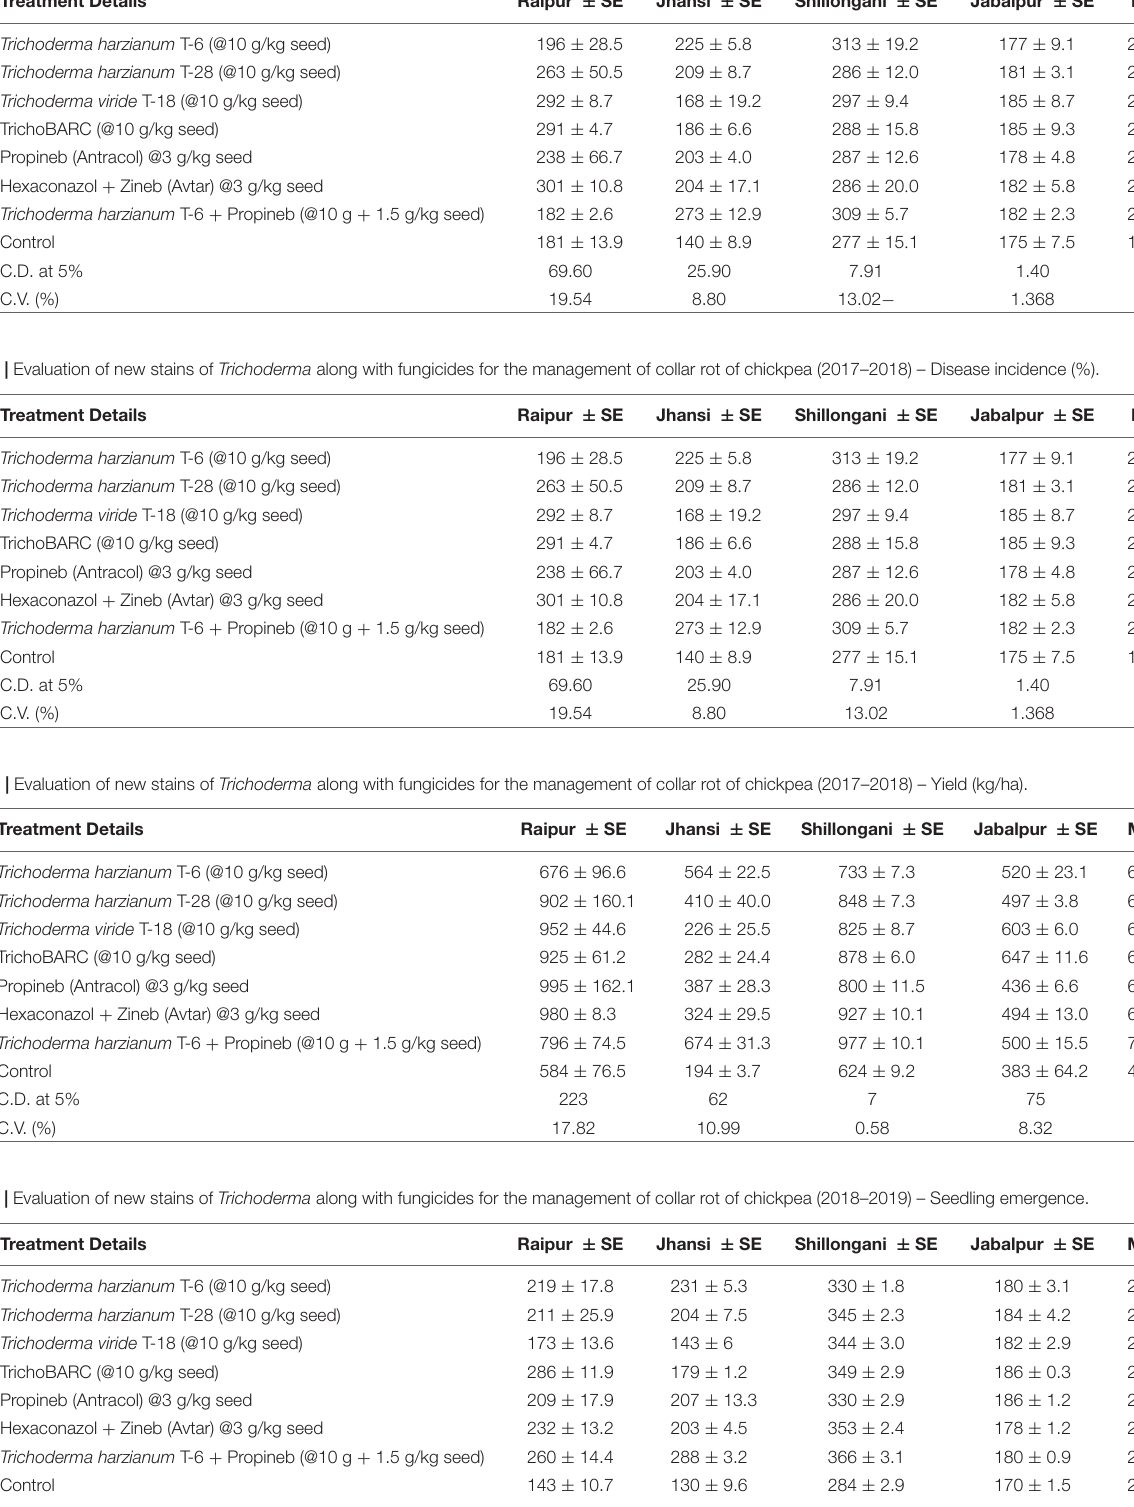
TABLE 2A | Evaluation of new stains of Trichoderma along with fungicides for the management of collar rot of chickpea (2017–2018) – Seedling emergence. S. No.